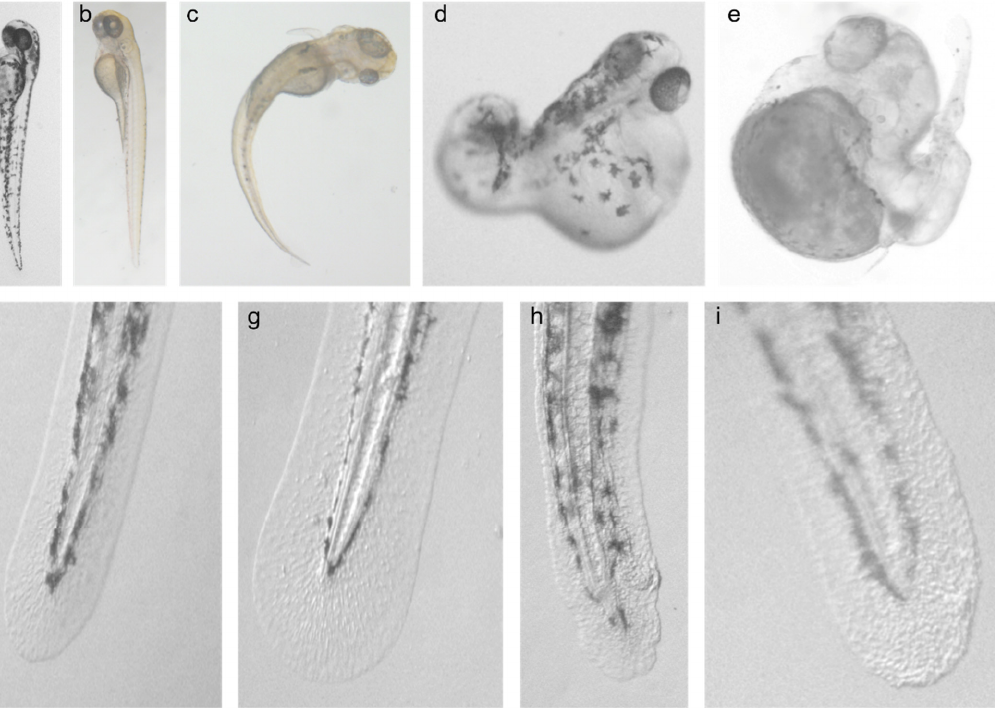
Figure 1. Developmental and cutaneous effects of Card14 overexpression. Three days post-fertilization (dpf) uninjected ( a ) and gfp -RNA ( b ) injected larvae as compared to larvae injected with zfCard14 RNA ( c – e ). The latter demonstrating a wide range of disturbed caudal development. Note asymmetric eye development in ( c , e ). Smooth surface, regular border and uniform pigmentation are seen in uninjected ( f ) and gfp- RNA injected ( g ) larvae; in contrast, irregular borders, spiky pigment and a “granular” surface are seen in larva injected with zf card14 ( h ) and hcard14 ( i )